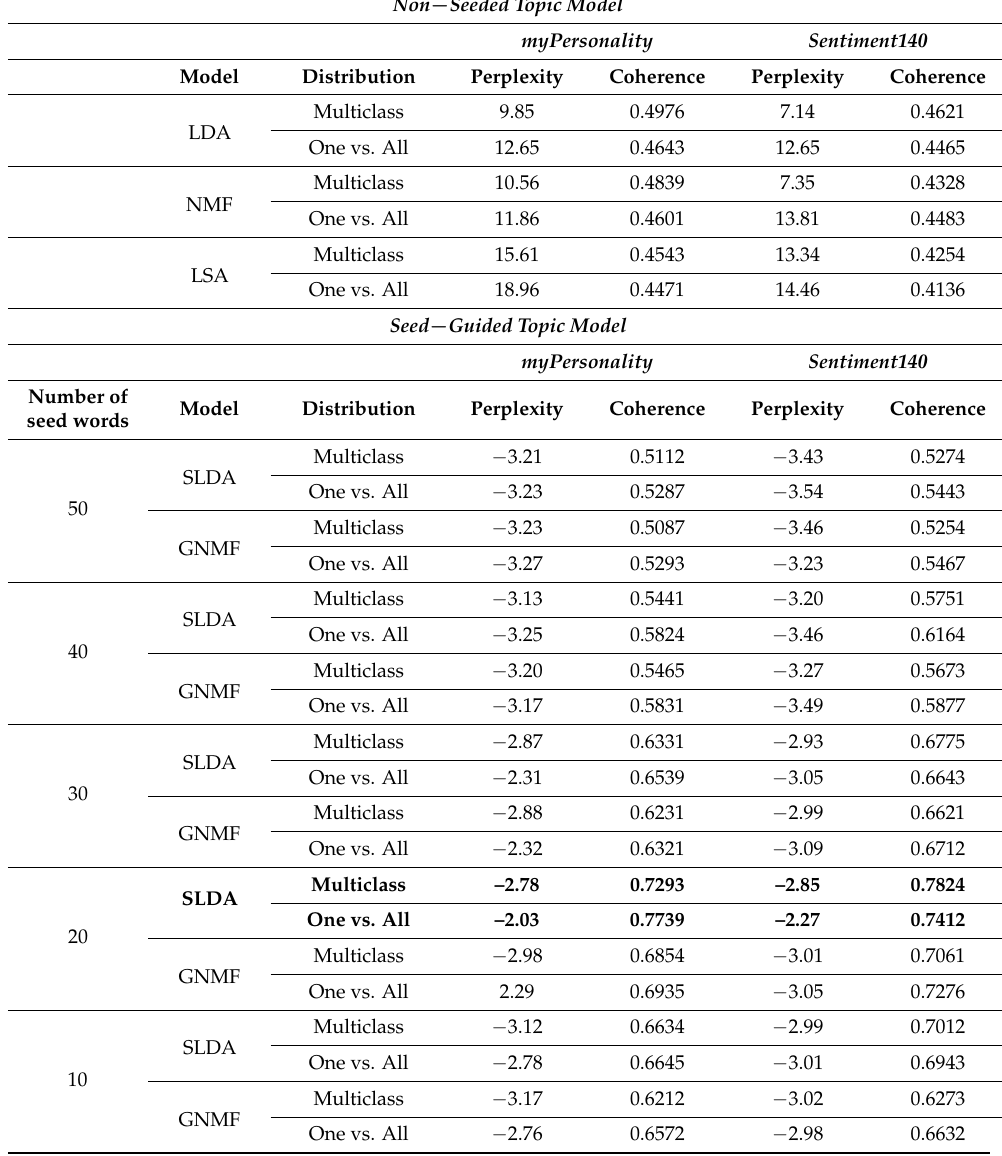
Table 4. Performance